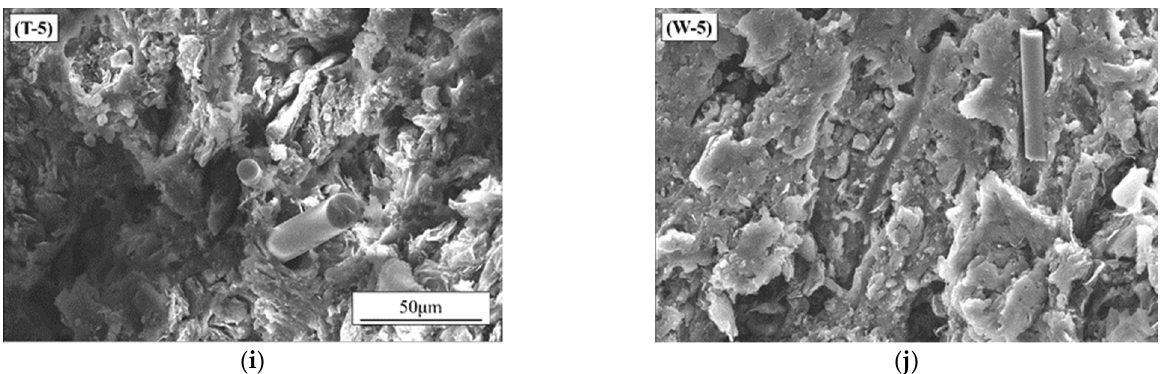
Figure 3. Tensile cross-sectional morphologies of materials with different Gr contents and the same CGF content (1 wt.%).( a , b ): 0 wt.% Gr,( c , d ):0.5 wt.% Gr,( e , f ):1.0 wt.% Gr,( g , h ):1.5 wt.% Gr,( i , j ):2.0 wt.% Gr.